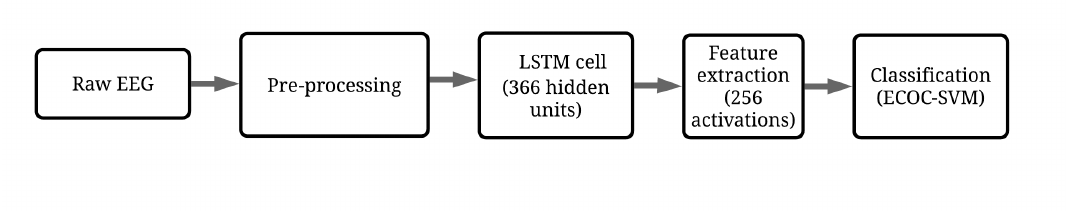
Figure 1. Proposed long short term memory (LSTM) error-correcting output coding support vector machine (ECOC-SVM)